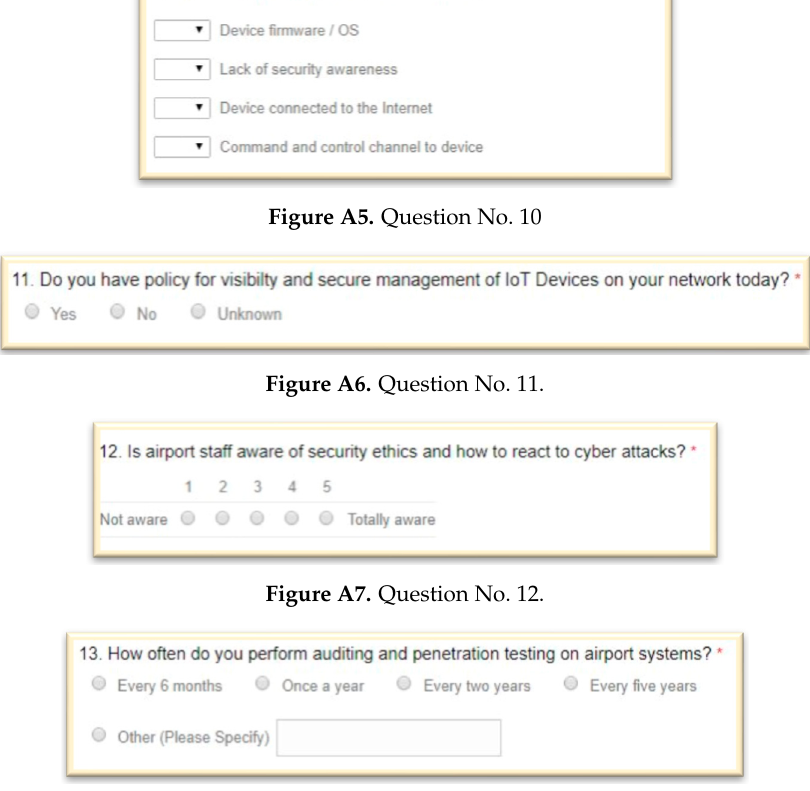
Figure A8. Question No 13.